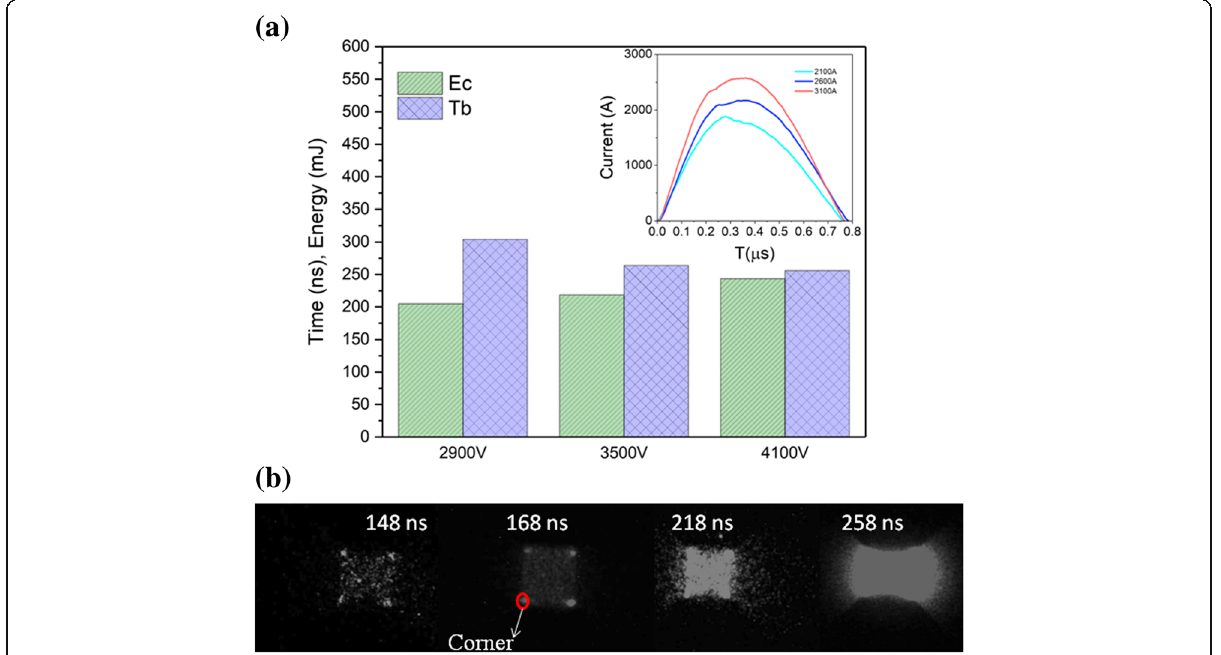
Fig. 5 a Experimental results of the exploding time and critical explosion energy with charging voltages ranging from 2900 to 4100V for energetic Al/Ni superlattice. b Images of the dynamic processes of energetic Al/Ni superlattice with the direction of towards the ultra-high-speed